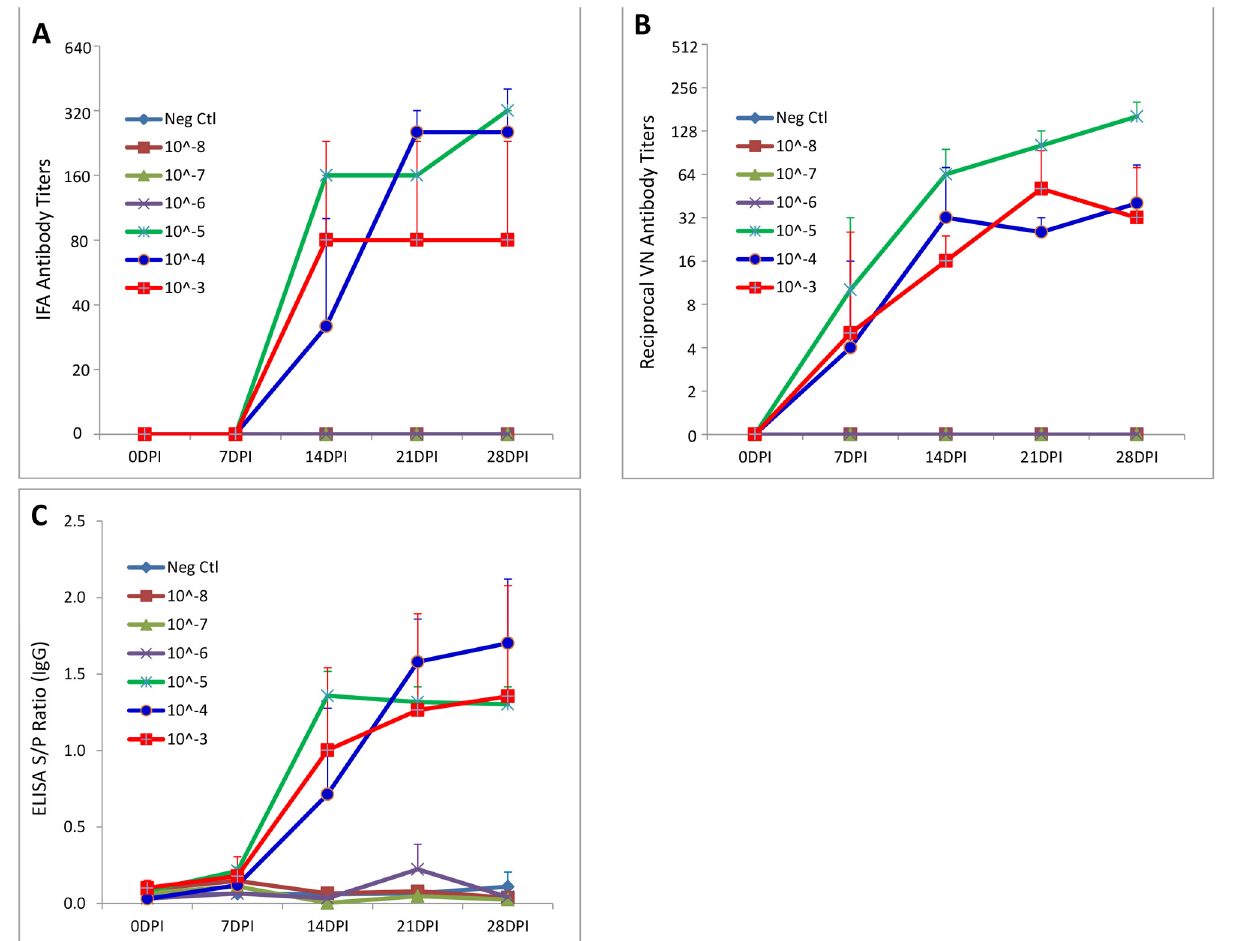
Fig 3. Serum antibody responses in 3-week-old pigs inoculated with serial dilutions of PEDV. IFA antibody titers (A), serum virus neutralizing antibody titers (B), and PEDV whole virus-based ELISA antibody titers (C) were shown for 3 pigs in each group that went through 28 days post inoculation.